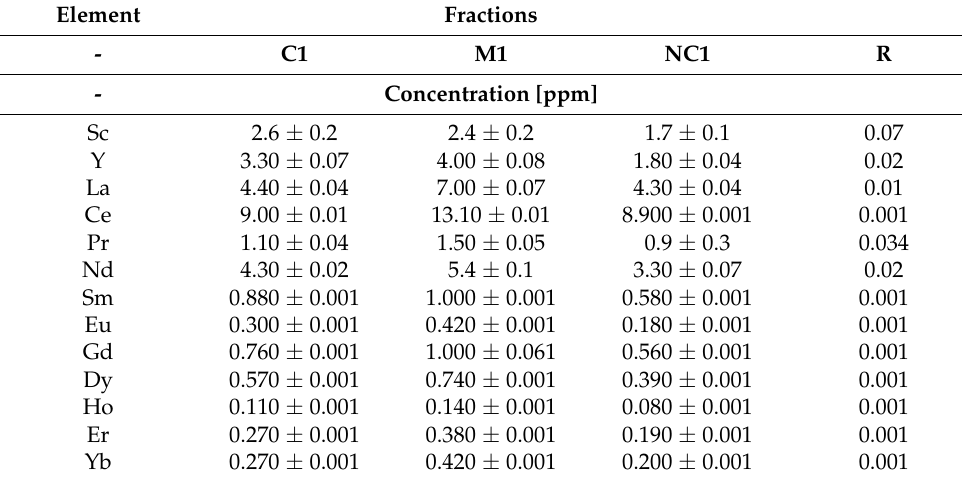
Table 5. The concentration of REEs in fractions C1, M1, and NC1